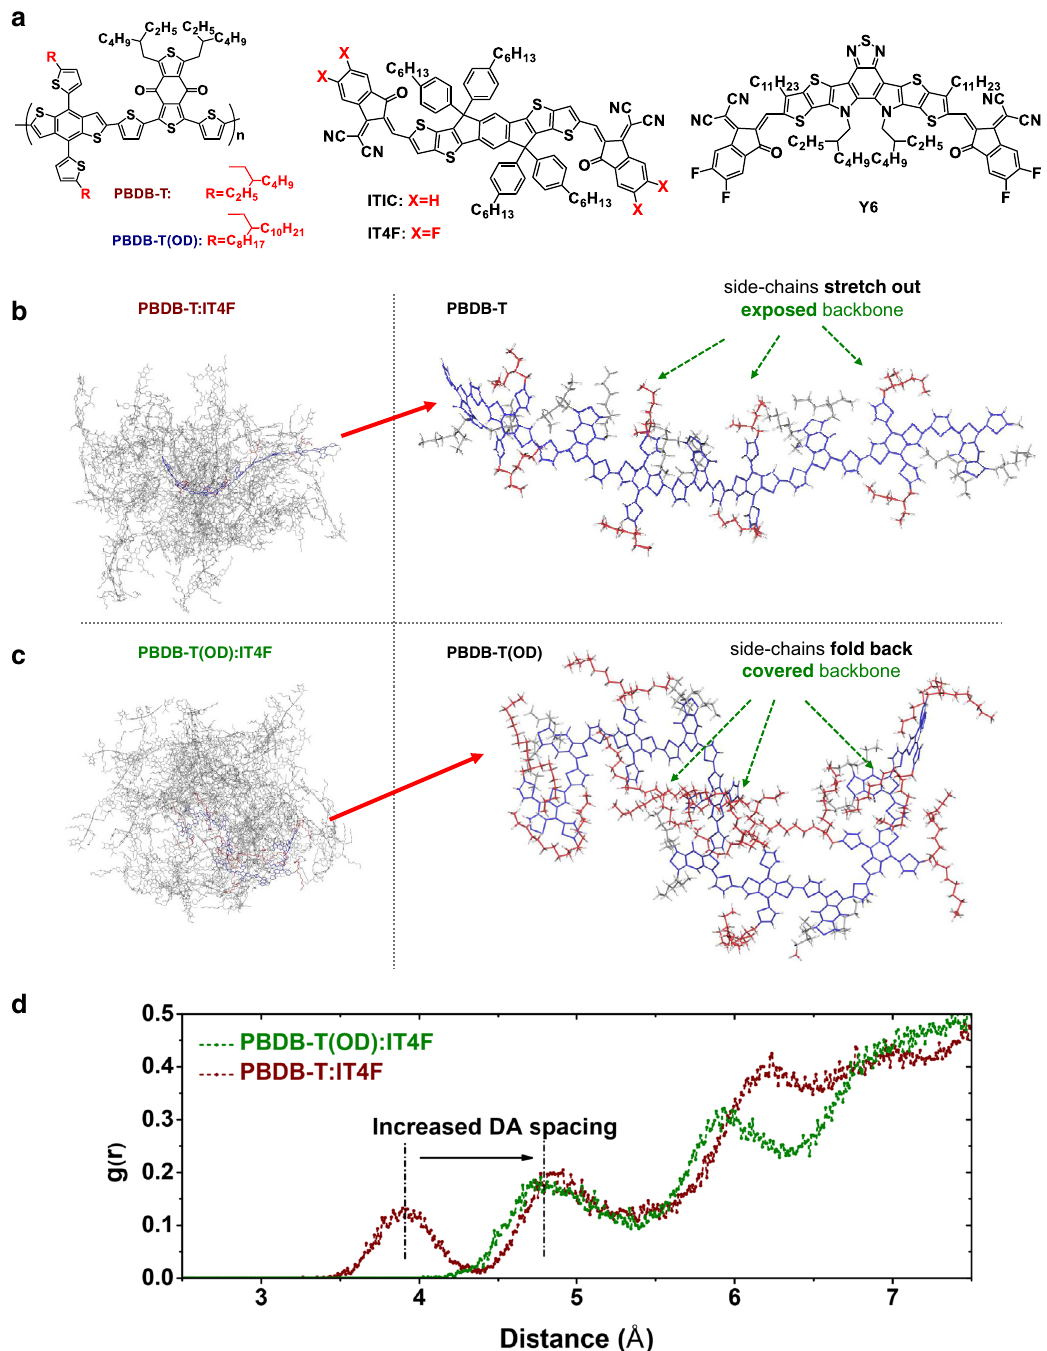
Fig. 3 Molecular dynamic simulations for the BHJ systems. a Chemical structures of PBDB-T, PBDB-T(OD), and the acceptor materials used. MD simulation results for b PBDB-T and c PBDB-T(OD) blended with IT4F. The side chains of PBDB-T stretch out, leaving the conjugated backbones highly accessible to IT4F, allowing for close parallel π stacking between the backbones and IT4F, while the side chains of PBDB-T(OD) fold back, covering the backbones, reducing the probability for IT4F to stack on the donor backbones. d RDF of the distances between the donor backbones and IT4F for the blends based on PBDB-T and